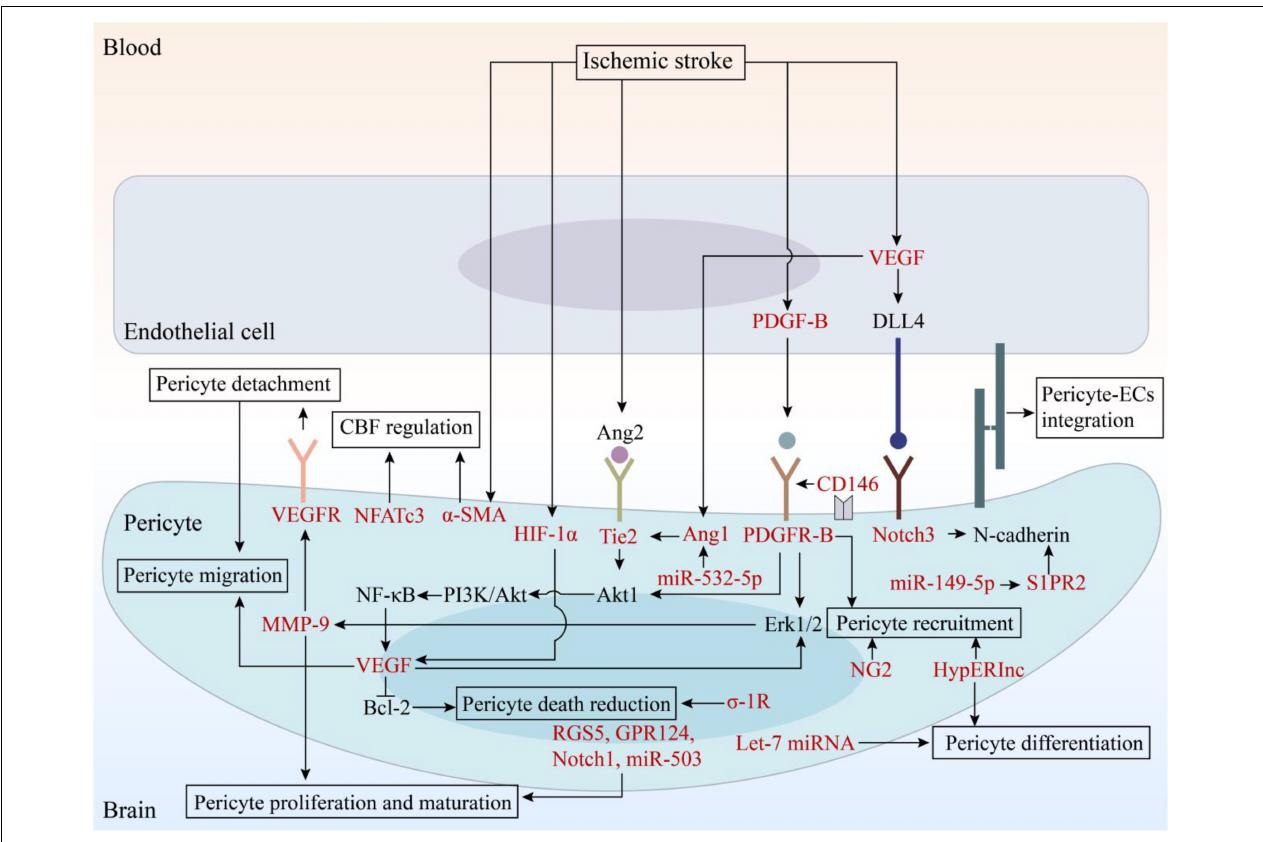
FIGURE 2 | The signaling pathways involved in angiogenesis and potential therapeutic targets. EC, endothelial cell; VEGF, vascular endothelial growth factor; VEGFR, vascular endothelial growth factor receptor; PDGF, platelet-derived growth factor; PDGFR, platelet-derived growth factor receptor; Ang, angiopoietin; DLL4, Delta-like ligand 4; HIF, hypoxia-inducible factor; MMP, matrix metalloproteinase; NF- κ B, nuclear factor kappa-B; Bcl-2, B cell lymphoma-2; PI3K, phosphatidylinositol 3-kinase; RGS5, regulator of G-protein signaling 5; GPR124, G protein-coupled receptor 124; σ -1R, sigma-1 receptor; NG2, neuron-glial 2; α -SMA, α -smooth muscle actin; NFATc3, nuclear factor of activated T-cells, cytoplasmic 3; HypERlnc, hypoxia-induced endoplasmic reticulum stress regulating lncRNA; S1PR2, sphingosine-1-phosphate receptor